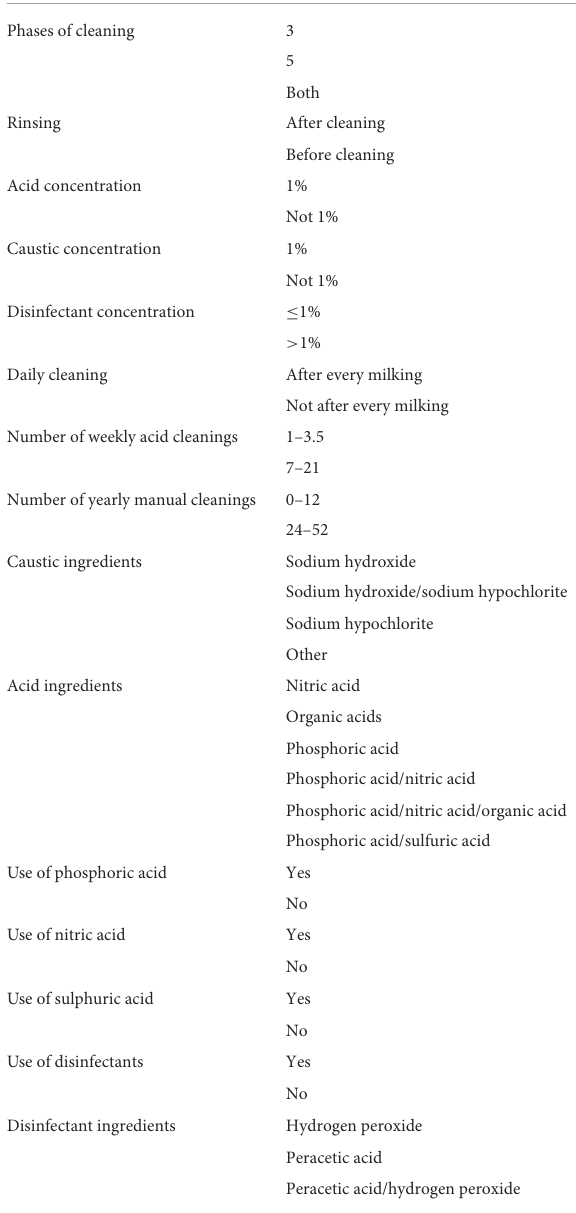
TABLE 2 The analyzed milking machine cleaning explanatory